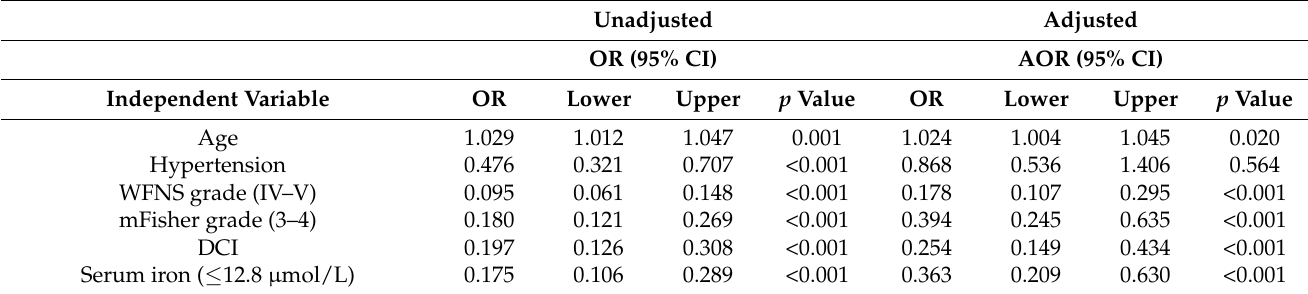
Table 4. Predictors for outcome of aSAH in multivariate